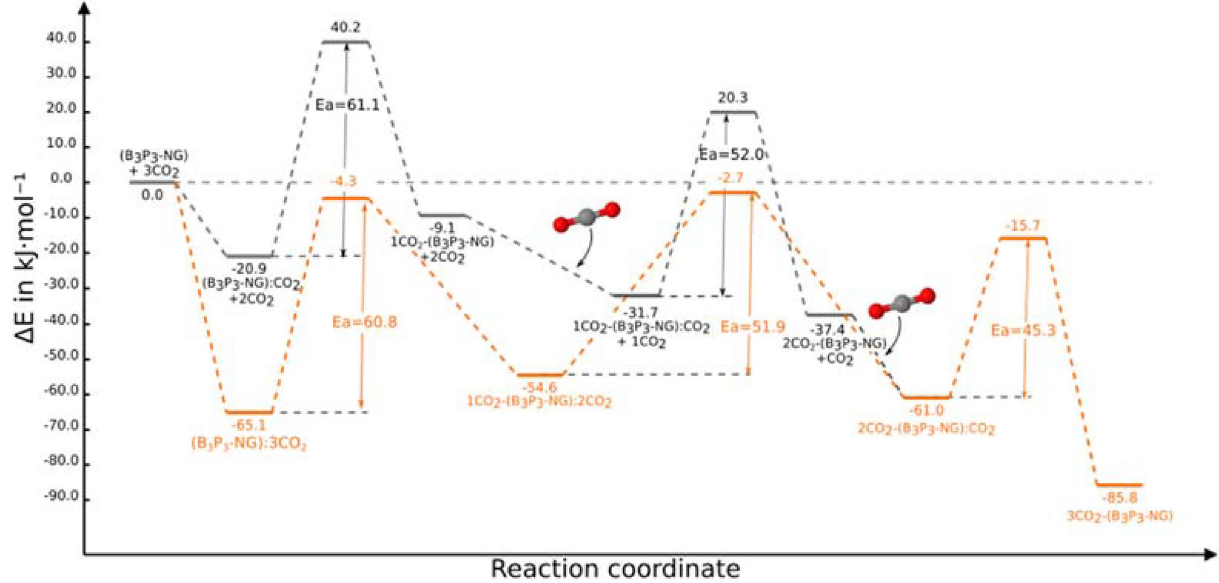
Figure 8. Comparison of the reaction profiles obtained by sequential addition of CO 2 molecules (black), and with 3 CO 2 molecules along the reaction profile (orange). The energies are in kJ mol –1 and calculated at M06-2X/6-311+ +G(3df,3pd)//M06-2X/6-31+G* computational